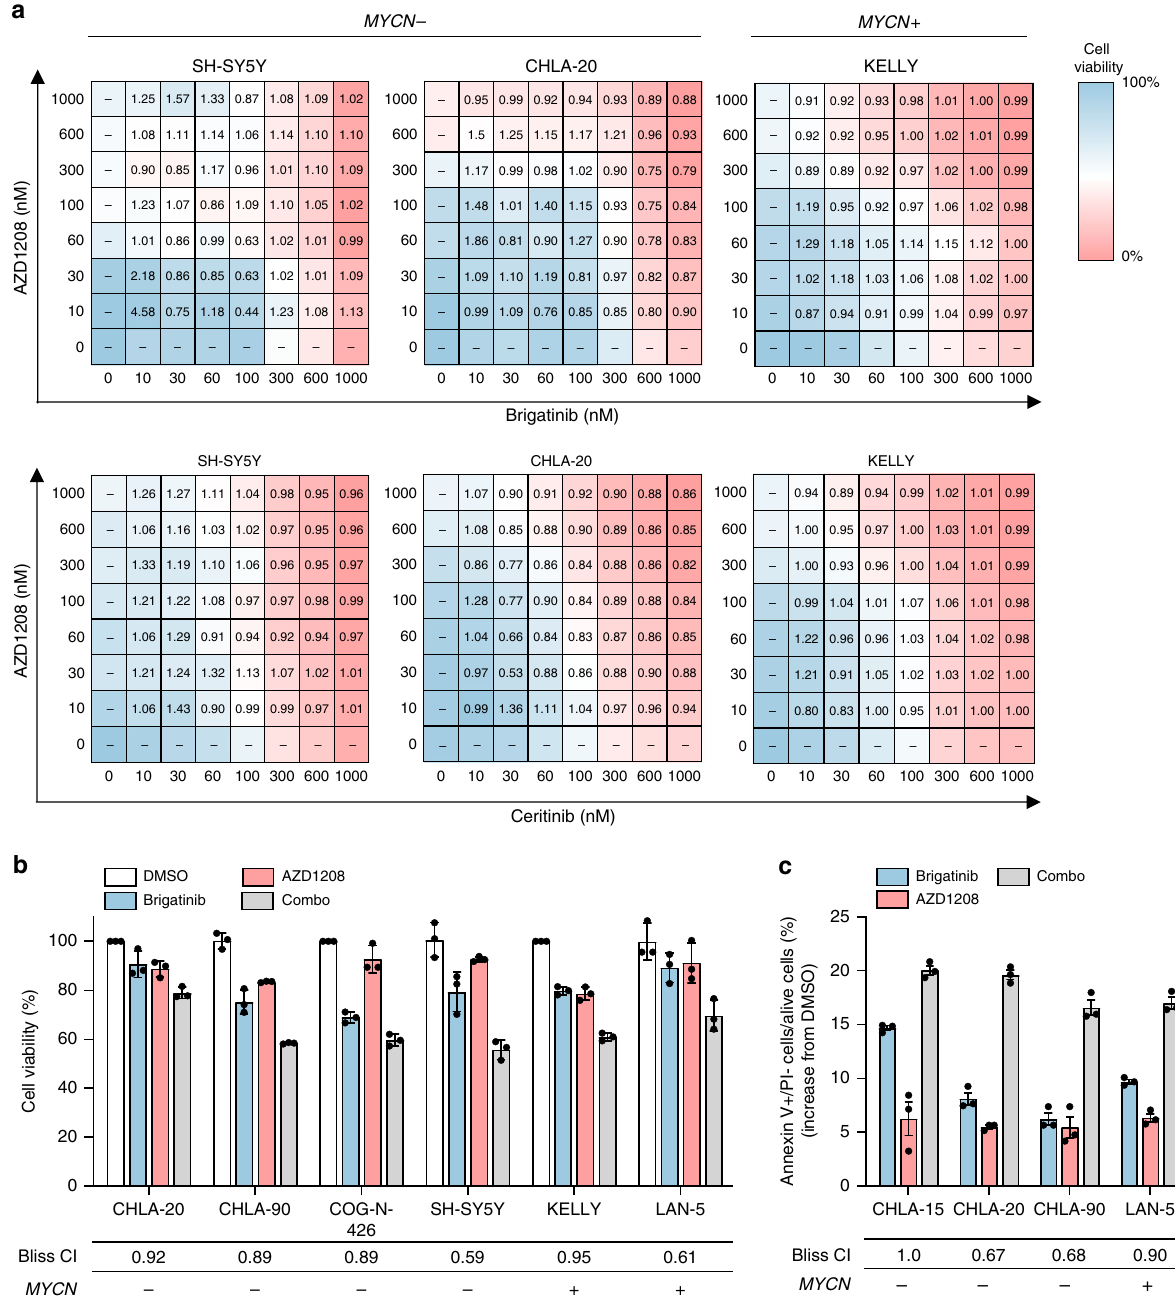
Fig. 4 ALK and PIM inhibitors exhibit mild synergism in ALK-positive NB cell lines. a Dose – response matrices of brigatinib vs. AZD1208 and ceritinib vs. AZD1208 in SH-SY5Y, CHLA-20, and KELLY cell lines. Heat maps visually represent inhibition of cell viability after 72 h of treatment, and numbers indicate Bliss combination index (CI) values for each dose pair. Data points are representative of two independent experiments. b Assessment of the interaction between brigatinib and AZD1208 in a panel of ALK-positive NB cell lines using the Bliss Independence model. CI < 1 indicates synergism, CI = 1 indicates additivity and CI > 1 indicates antagonism. Data points represent means± s.d. of triplicate experiments. Brigatinib was used at the approximate ED 10 concentration for each cell line ED 10 (CHLA-20) = 30 nM; ED 10 (CHLA-90) = 30 nM, ED 10 (COG-N-426) = 30 nM, ED 10 (SH-SY5Y) = 30 nM, ED 10 (KELLY) = 30 nM, ED 10 (LAN-5) = 3 nM). c Apoptosis analysis of ALK-positive NB cell lines treated with DMSO, brigatinib (1 µ M), AZD1208 (1 µ M), or a combination of the two (combo) for 48 h. Drug interaction was assessed using the Bliss Independence model, as described above. Data points represent means ± s.d. of triplicate experiments. Source data for this fi gure are provided as a Source Data fi